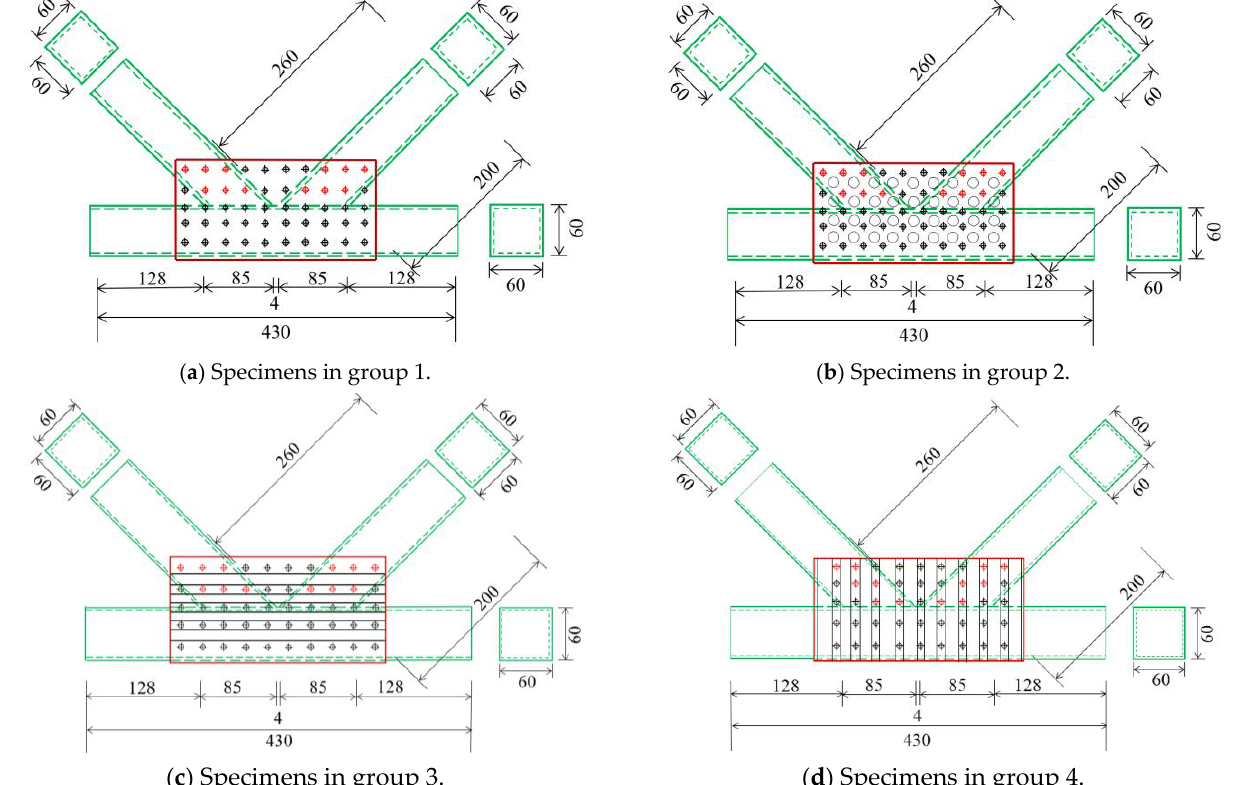
Figure 4. Geometries of four typical K-joints (unit in mm).